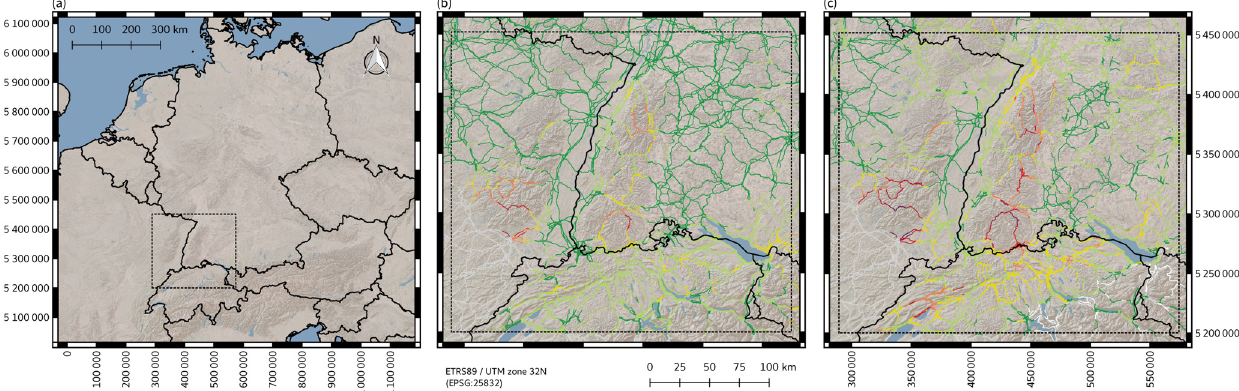
Figure 3. Overview of the target region: (a) location of the region in central Europe and median of the increase in landslide-triggering climate events for (b) the near future and (c) the remote